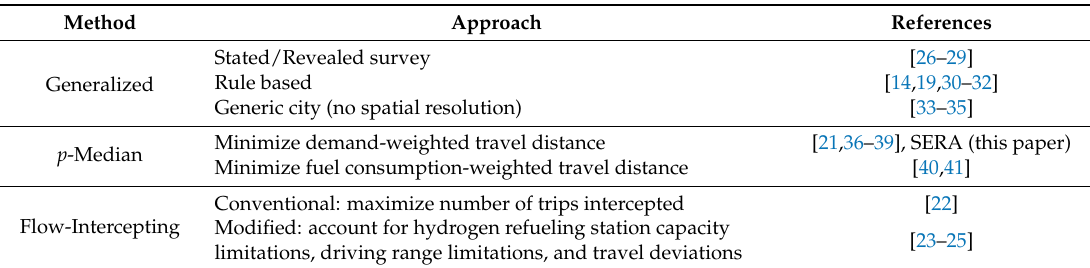
Table 1. Local hydrogen refueling station placement